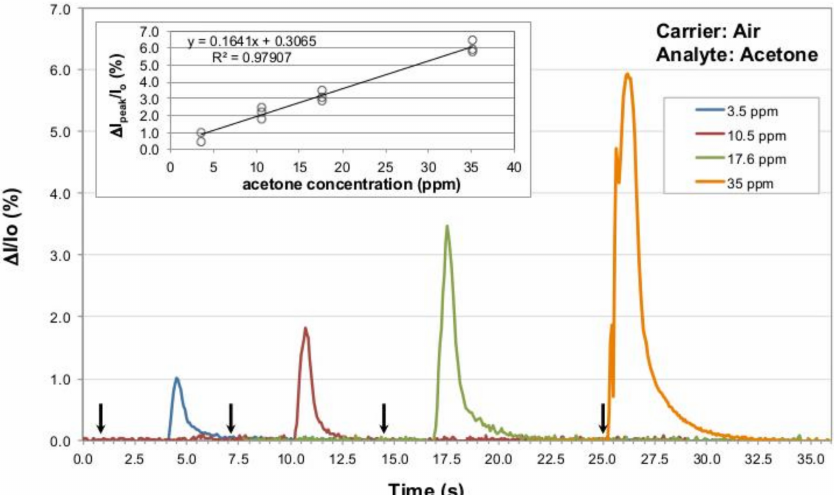
Figure 5. Current percentage change normalized to the baseline current I 0 for a P3HT nanofibers sensor tested versus increasing acetone concentrations (namely 3.5, 10.5, 17.6 and 35 ppm) in air as the gas carrier, at 25 ◦ C. The black arrows mark the end of the analyte injection procedure (approximately three seconds prior to observe the sensor response onset; for the 17.6 ppm this time was a bit lower, about 2.5 s, and for the 35 ppm the time was extremely short, around 0.1–0.2 s). The inset shows the linear relation between the ∆ I peak /I 0 ratio and the corresponding tested acetone concentrations for all injections conducted in air as the gas